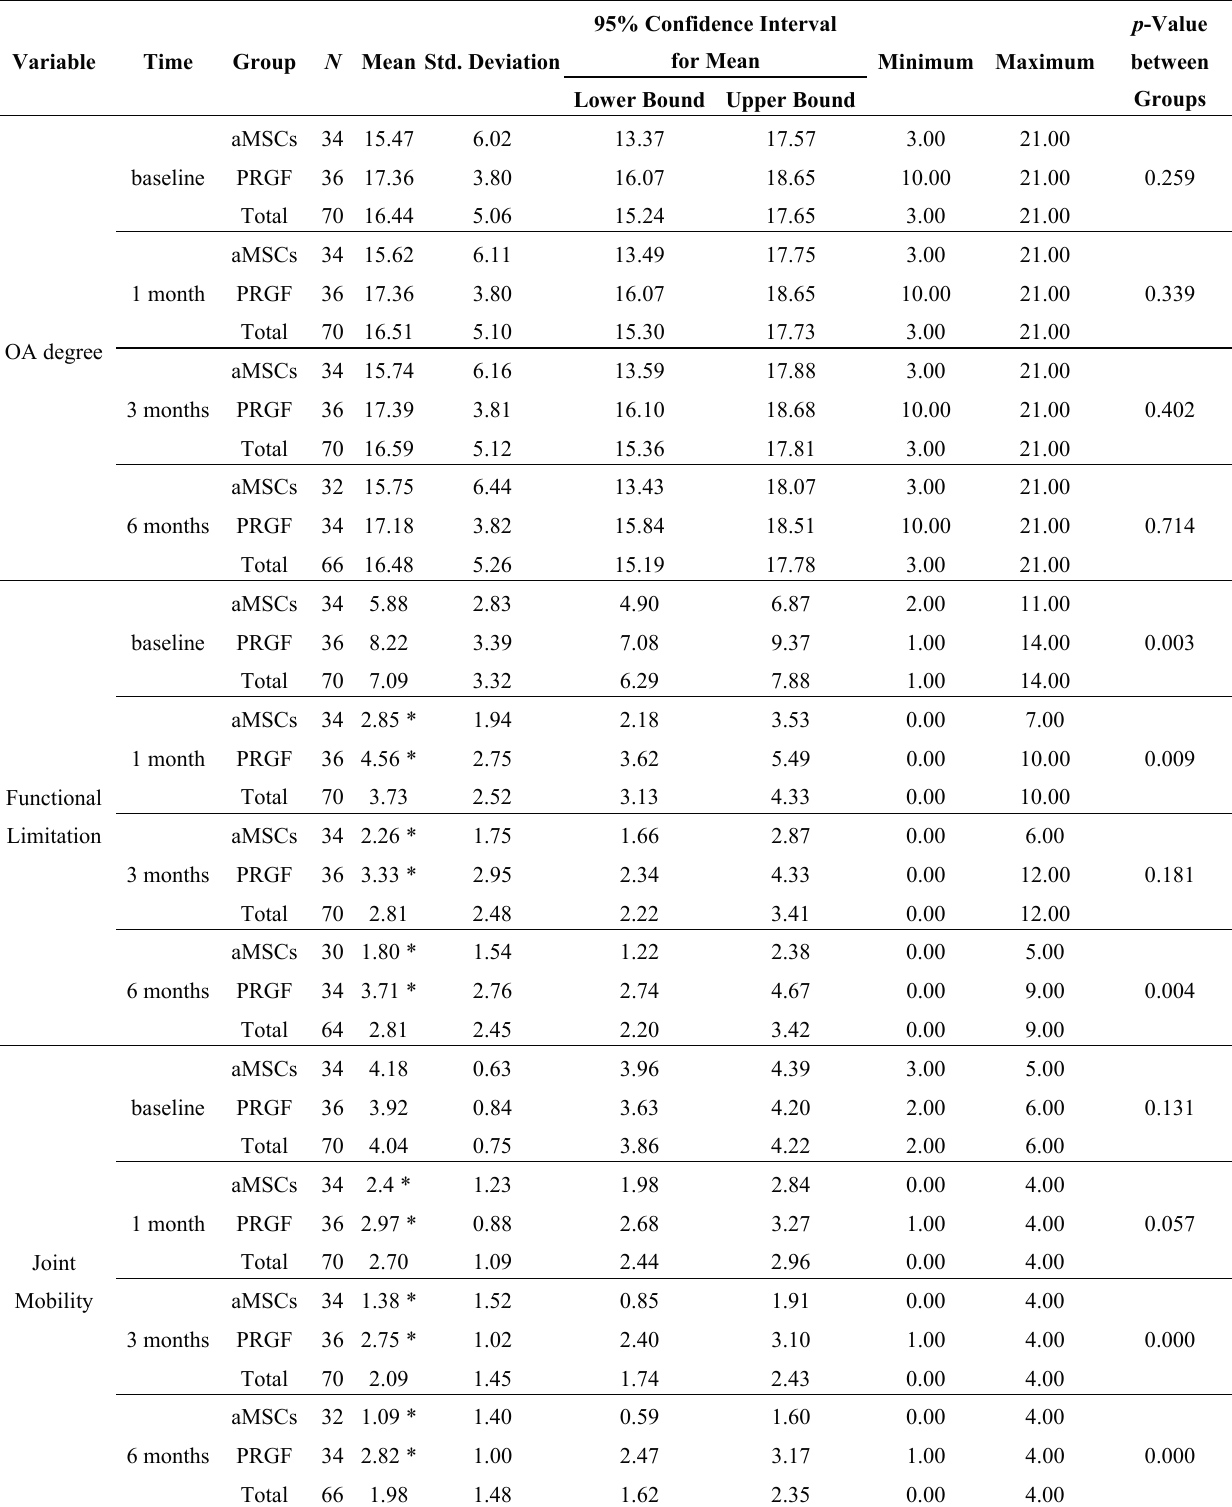
Table 3. Mean ± SD of the functional limitation, joint mobility and range of motion, at baseline, one, three and six months after treatment. Kruskal-Wallis results between groups. * Differences with